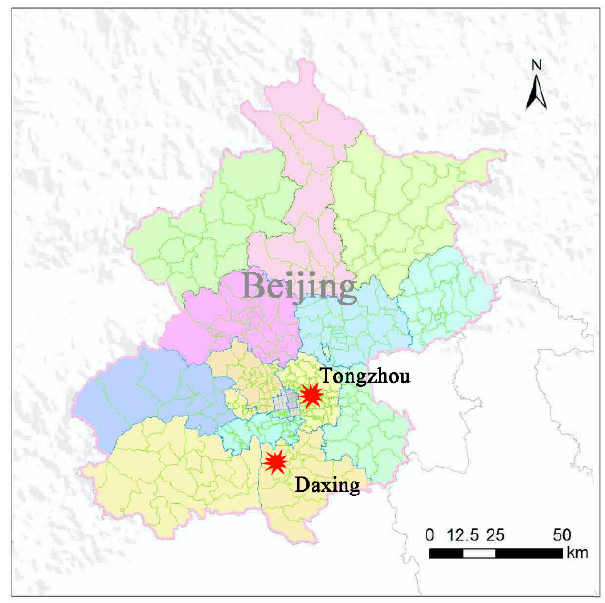
Figure 18. The locations of Daxing and Tongzhou districts in Beijing.